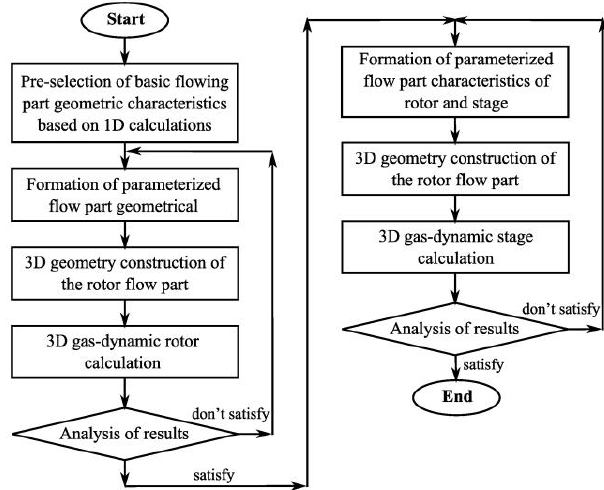
Figure 1: Flowchart of turbine stage flow designing Figure 1. Flowchart of turbine stage flow designing